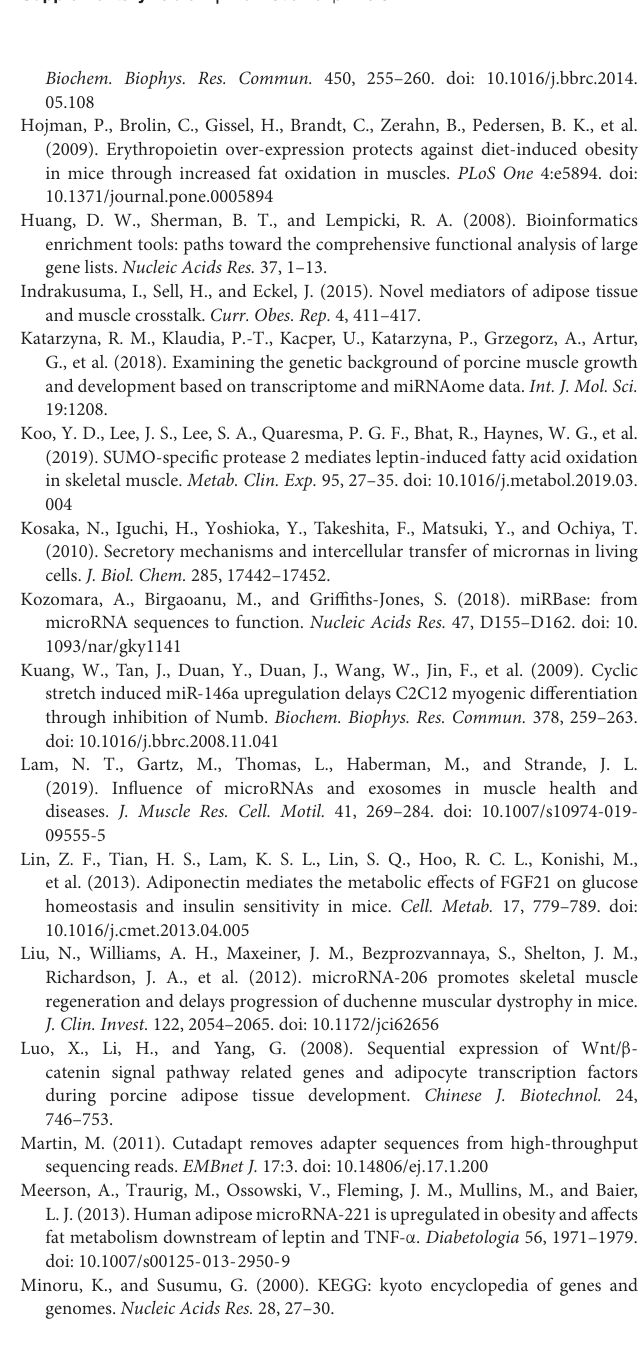
Supplementary Figure 1 | Identification of exosome special marker. Cell lysate: Whole cell lysate by RIPA. A-EXO, exosomes from adipose; M-EXO, exosomes from muscle. Supplementary Figure 2 | Validation of DE miRNAs change after treatment with exosome. NC, Adipocytes treated with PBS; M-EXO, Adipocytes treated with M-EXO. ** P < 0.01. Supplementary Figure 3 | Integrated analysis of miRNAs – mRNA network. Green triangle: DE miRNA of M-EXO; Red triangle: DE miRNA of A-EXO; Blue circle: target gene of miRNA. Supplementary Table 1 | Information of